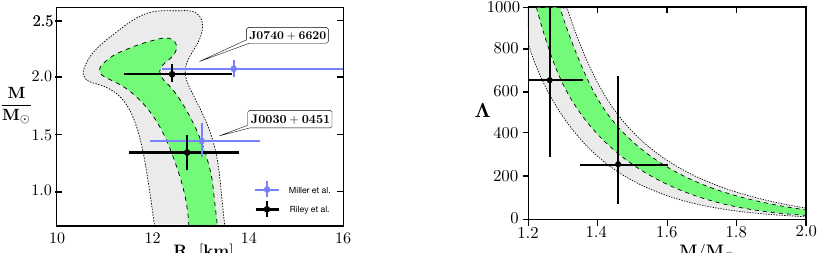
Figure 3. Inferred 95% and 68% credible bands for the mass-radius relation (left) and the mass dependence of the tidal deformabilty Λ (right) of neutron stars [16] based on the empirical EoS of Fig.2. Data for masses and radii from [7–10]. Tidal deformabilty data (GW170817) from